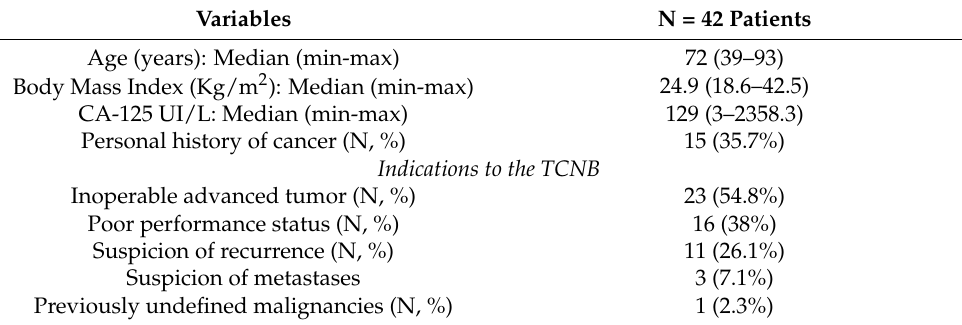
Table 1. Characteristics of the patients.